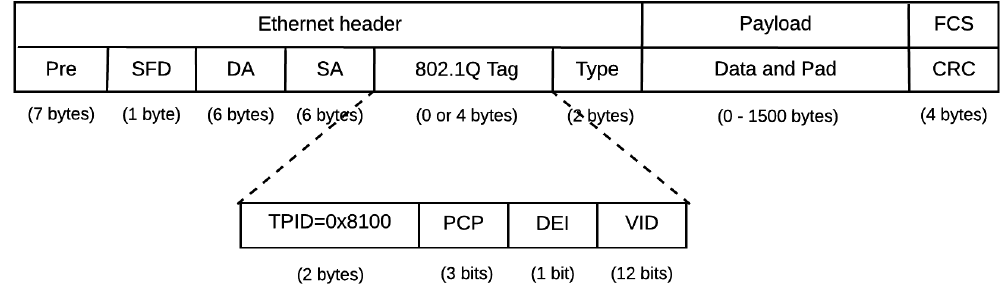
Figure 6. T-AeroRing frame structure. Table 1. AeroRing priority